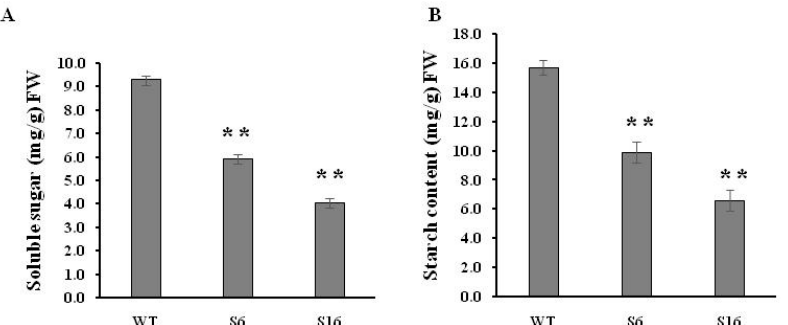
Figure 7. Soluble sugar and starch contents in mature anthers of WT and osros1a mutants. ( A ) Total soluble sugar content in mature anthers of WT and osros1a mutants. ( B ) Starch content of mature anthers in WT and osros1a mutants. Anthers were sampled at stage 13 (the mature pollen stage). Data are means ± SD ( n = 3). ** denote significant differences from WT at p < 0.01 level.